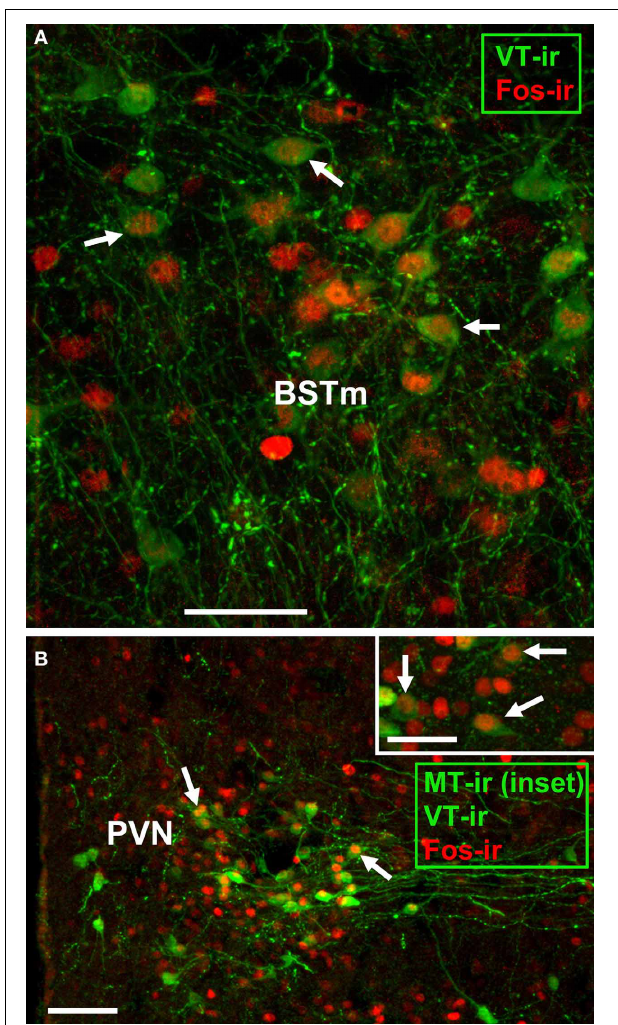
FIGURE 1 | Representative immunocytochemical colocalization of Fos with VT and MT. (A,B) Colocalization of Fos (red; Alexa Fluor 594) and VT (green; Alexa Fluor 680 pseudocolored for visibility) in the BSTm of a male (A) and PVN of a female (B) . The inset in panel B shows colocalization of Fos (red; Alexa Fluor 594) with MT (green; Alexa Fluor 680 pseudocolored for visibility) in the PVN of a male. Scale bars = 50 µ m in (A,B) inset; 100 µ m for (B) . POM, medial preoptic